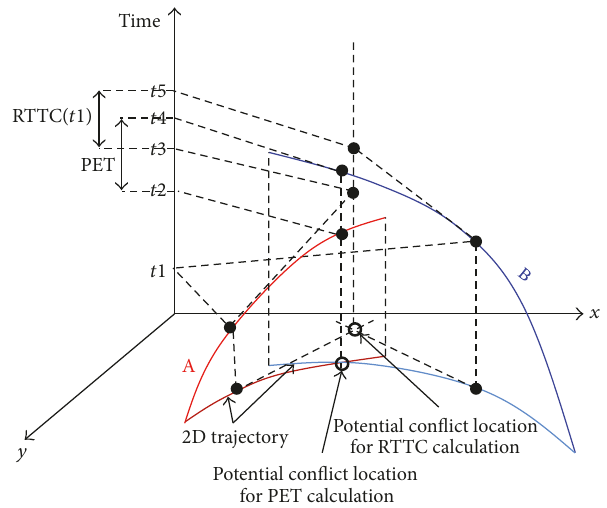
Figure 5: RTTC and PET of pedestrian-vehicle conflict identified on the time-space diagram (modified from